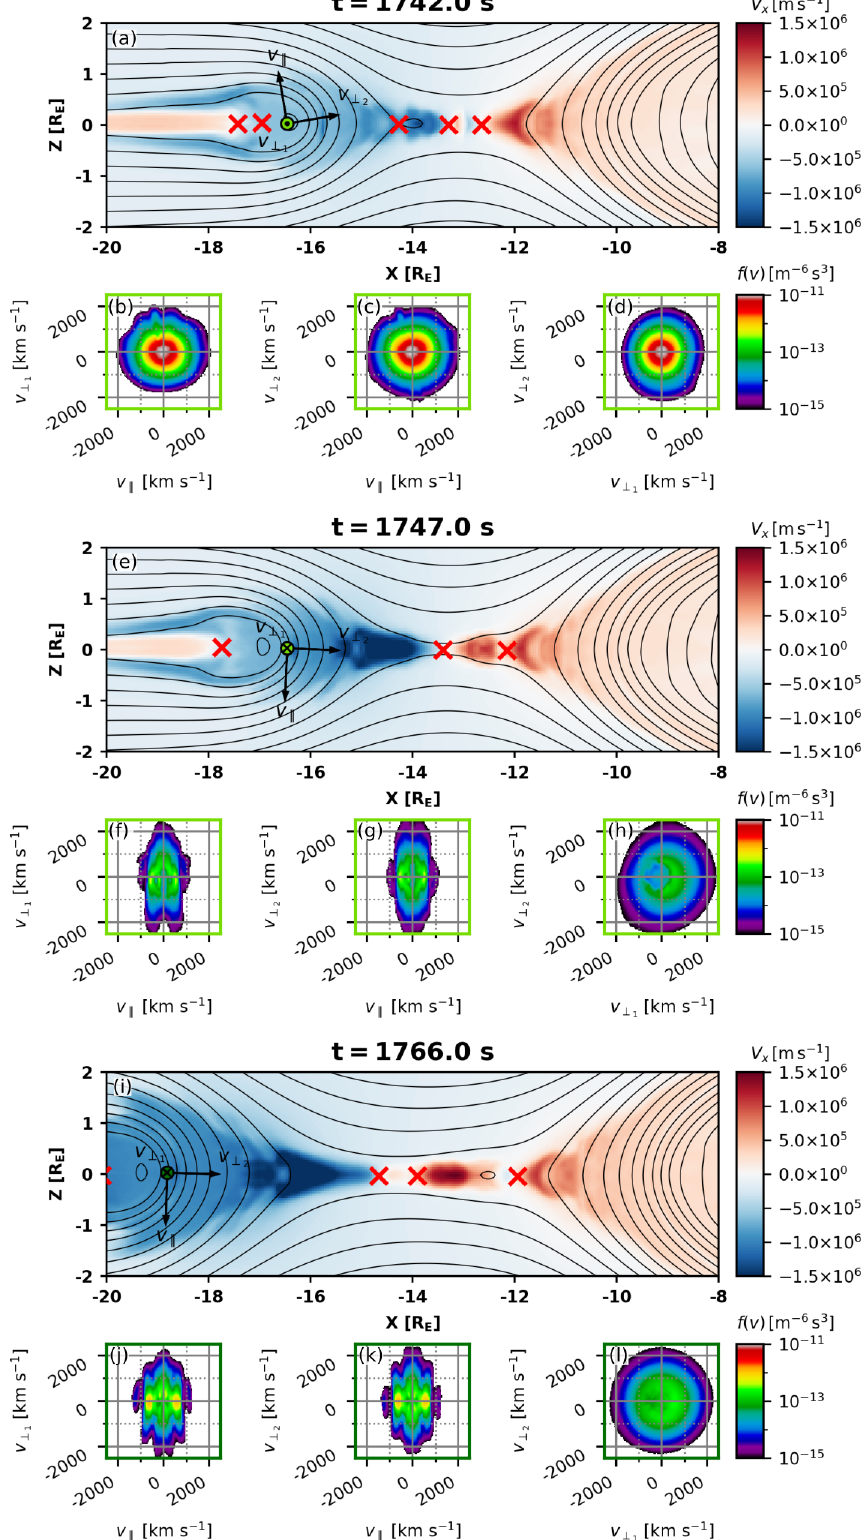
Figure 4. Same format as in Fig. 3, but focusing on the plasma tailward from the major X line at (a–d) t = 1742 . 0s, (e–h) t = 1747 . 0s, and (i–l) t = 1766 . 0s. Note that the plasma monitored in (i) – (l) is located on the same magnetic field line as in (e) – (h) after it has convected